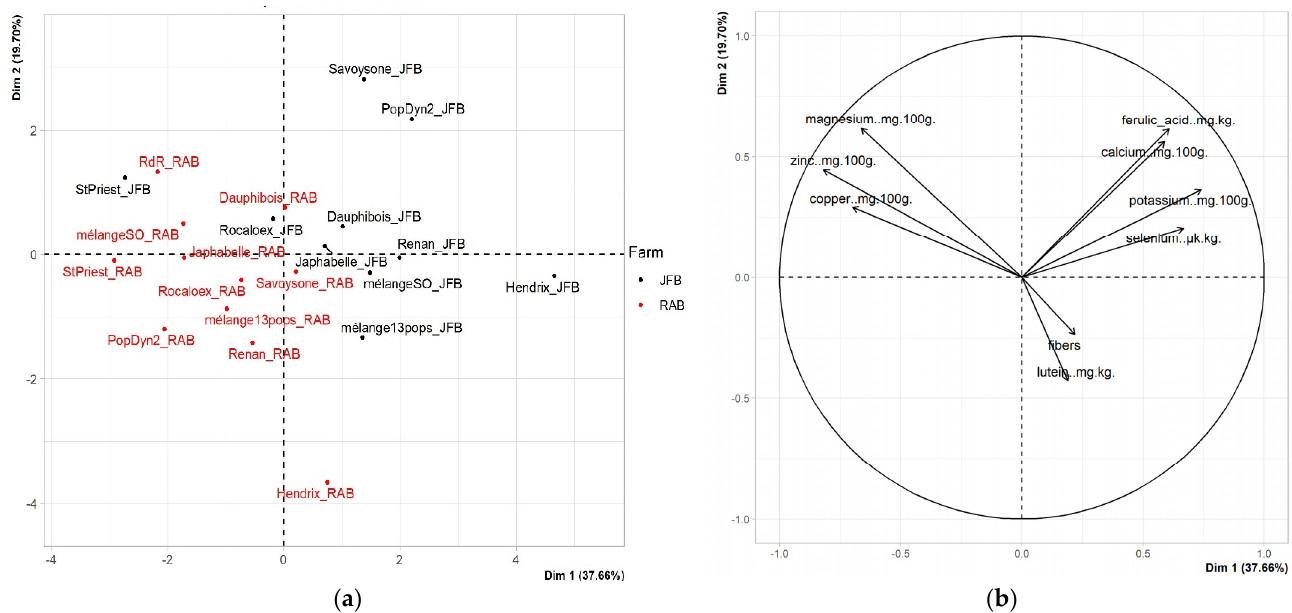
Figure 5. Results of the PCA on eight nutritional variables for the 21 wheat varieties*farm: ( a ) individual graph and ( b ) correlation circle. Table 2. Mean values and ANOVA Significance for lutein, selenium (Se), copper (Cu), ferulic acid, calcium (Ca), magnesium (Mg), potassium (K), zinc (Zn) and fibers. Signifiance codes: 0 ‘***’ 0.001 ‘**’ 0.01 ‘*’ 0.05 ‘.’ 0.1 ‘ ’ 1 ‘a,b,c’ letter indicates significant differences between